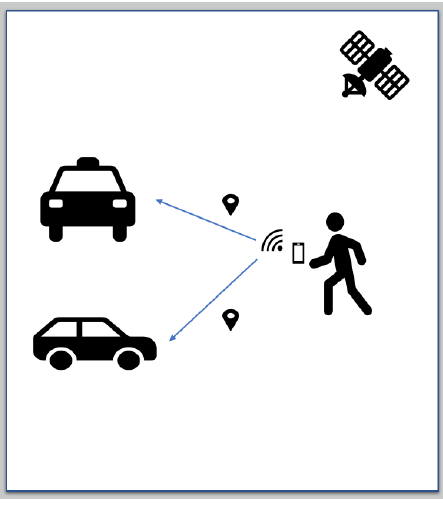
Figure 3. WiFi safe basic idea in Reference [35].